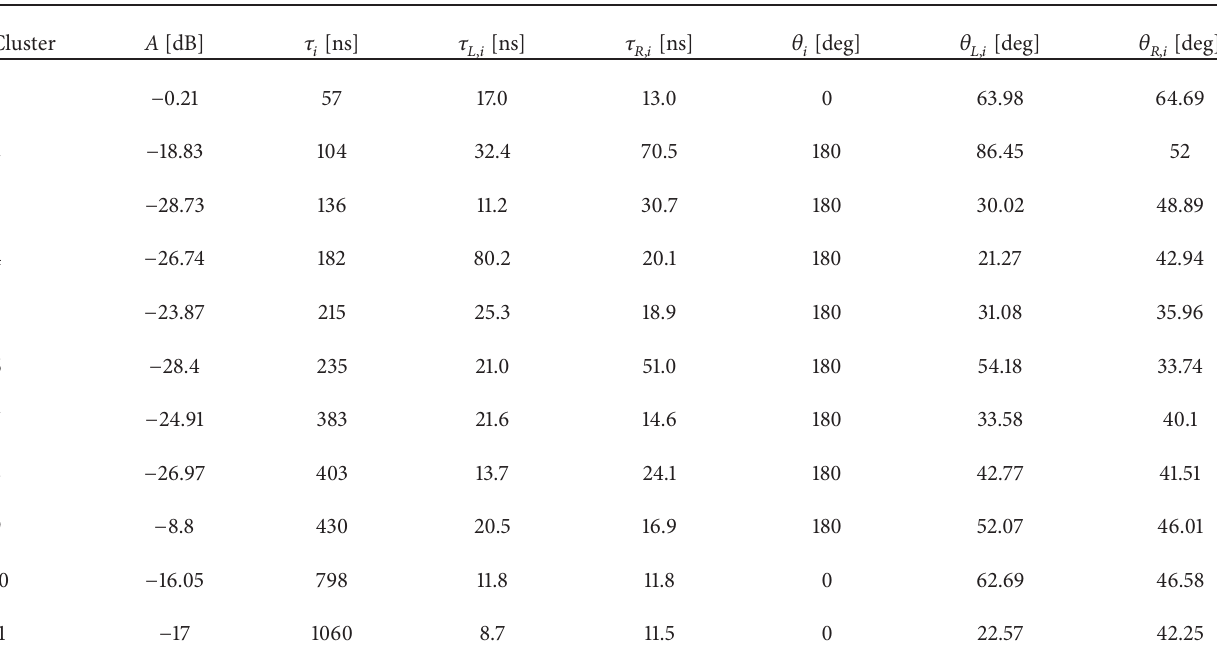
Table 2: Channel parameters extracted at the position of